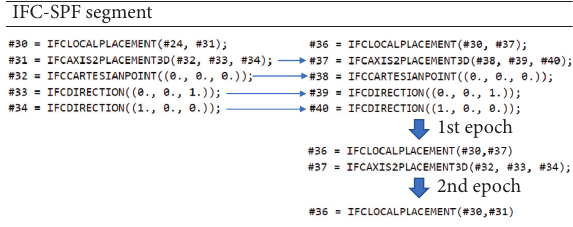
Figure 6: Recursive redundancy in